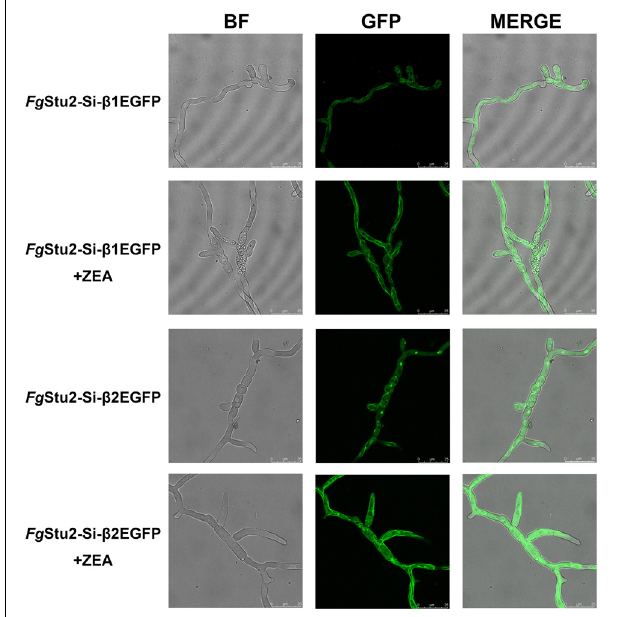
FIGURE 6 | Roles of Fg Stu2 gene in microtubule polymerization. Fresh spores (10 5 ) of Fg Stu2-Si- β 1EGFP and Fg Stu2-Si- β 2EGFP were first incubated into 20 ml of yeast extract-peptone-dextrose medium (YEPD) with or without 30 µ M zearalenone (ZEA) and then put it on an orbital shaker (175 rpm) at 25 ◦ C to germinate for 10 h and then spotted 5 µ l of culture onto the slides for confocal micro examination. Bar = 25 µ